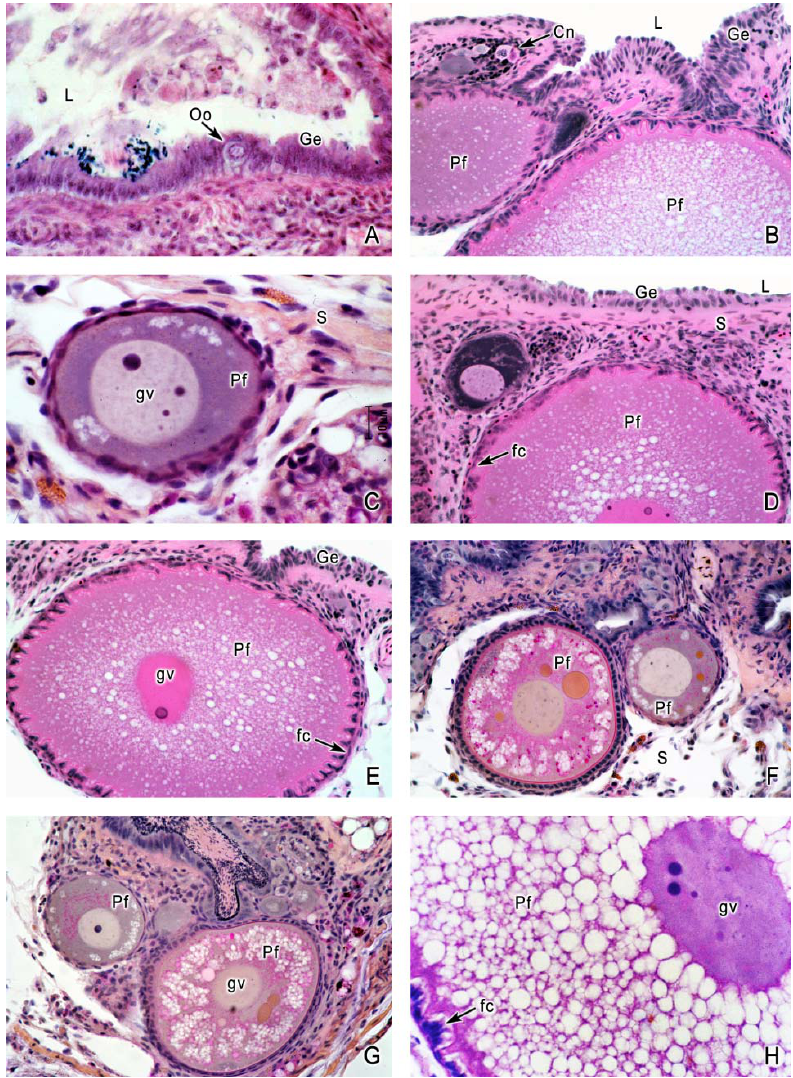
Figure 3. Morphology of the germinal cells during oogenesis. Germinal cells from oogonia to previtellogenic follicles. ( A ) Oogonium (Oo) of Heterandria formosa observed in the germinal epithelium (Ge) among somatic cells. The germinal epithelium borders the ovarian lumen (L). The oogonium is spherical and possesses light ooplasm. 500 × . ( B ) Oocyte of Poecilia reticulata in chromatin-nucleolus stage (Cn) at the initiation of meiosis. Germinal epithelium (Ge), previtellogenic follicles (Pf), and ovarian lumen (L) are seen. 78 × . ( C ) Previtellogenic follicle (Pf) of Heterandria formosa with basophilic ooplasm, the germinal vesicle (nucleus) (gv) contains several nucleoli. Stroma (S) surrounds the follicle. 500 × . ( D ) Previtellogenic follicle (Pf) of Poecilia reticulata containing lipid droplets around the germinal vesicle. Follicular cells (fc) are seen around the oocyte. Stroma (S) surrounds the follicle. The germinal epithelium (Ge) borders the ovarian wall (L). 78 × . ( E ) Previtellogenic follicle (Pf) of Poecilia reticulata , with abundant lipid droplets in the ooplasm. The germinal vesicle (gv) and follicular cells (fc) are seen. Germinal epithelium (Ge). 78 × . ( F , G ) Previtellogenic follicles (Pf) of Heterandria formosa with lipid droplets. The ooplasm also contains cortical alveoli seen as small red granules. The germinal vesicle (gv) is seen. Stroma (S). 78 × . ( H ) Detail of previtellogenic follicle (Pf) of Xiphophorus hellerii with abundant lipid droplets. The germinal vesicle (gv) contains several nucleoli. The follicular cells (fc) are seen around the oocyte. 200 ×